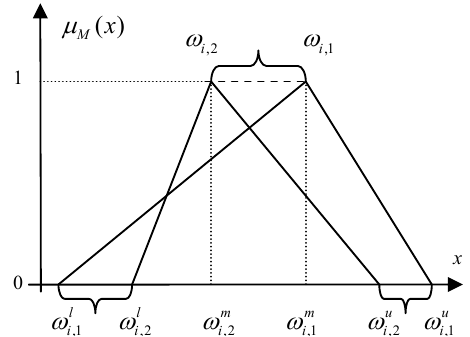
Fig. 6. One case of combining two triangular fuzzy weights from 2 experts